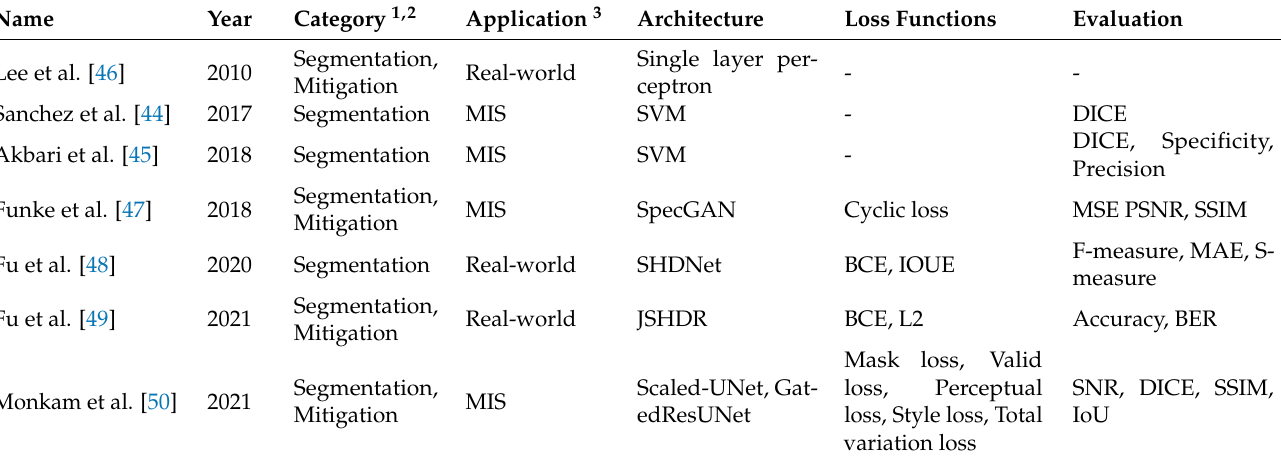
Table 2. Summary of the machine learning based methods for specular highlight segmentation in real-world